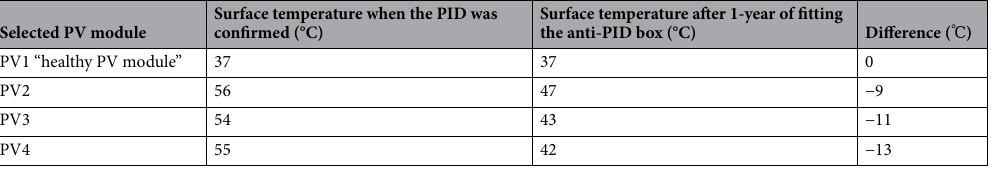
Fig. 7, you can see the monthly PR ratio of the PV strings for each month. As shown in Fig. 7a, the healthy PV module maintains a superior performance over a period of two years, with a PR ranging from 88 to 96%. PV strings (1, 2, 3 and 4) that were confirmed to have PID had exactly the same PR ratio, even when the anti-PID box was installed, their PR remained consistently below 75% even after the anti-PID box was installed, as shown in Fig. 7b,c.